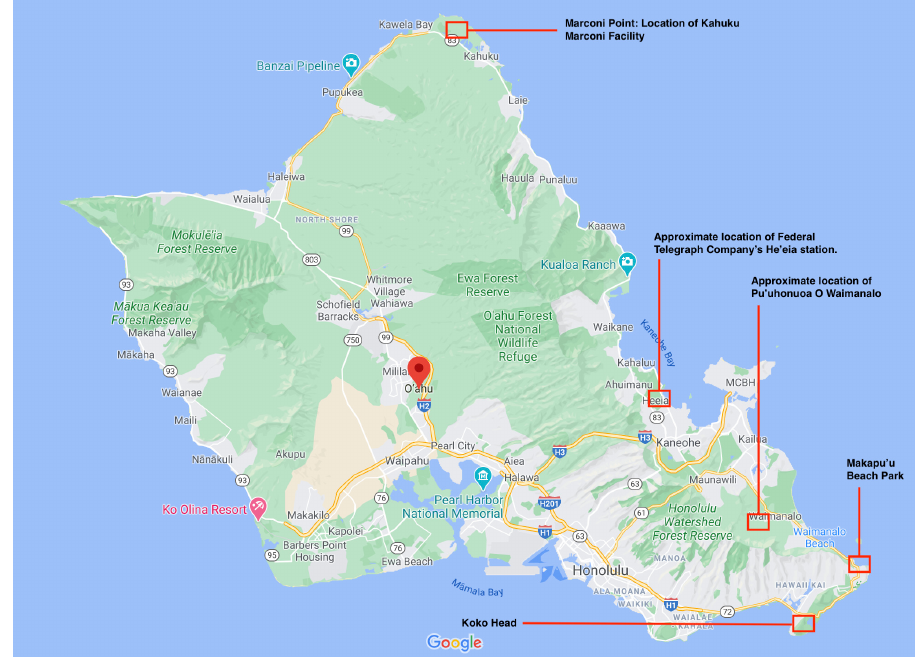
Figure 4: Map of O‘ahu, showing location of major Marconi installations and other relevant sites. Map: Google Maps. Annotations by the